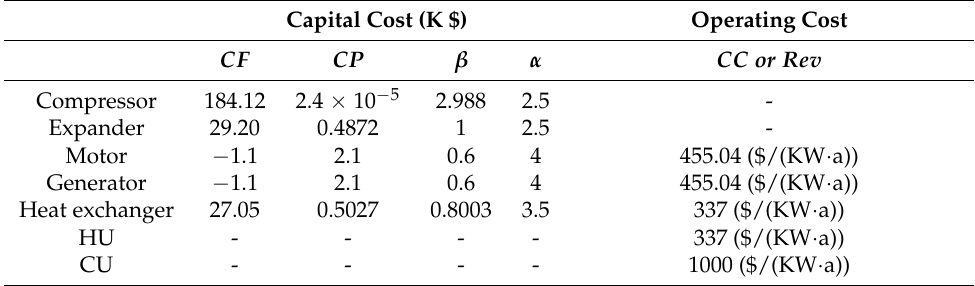
Table 4. Cost coefficients for equipment and utilities ( CF : fixed cost for different equipment; CP : appropriate cost coefficient for associated equipment; CC : unit cost for